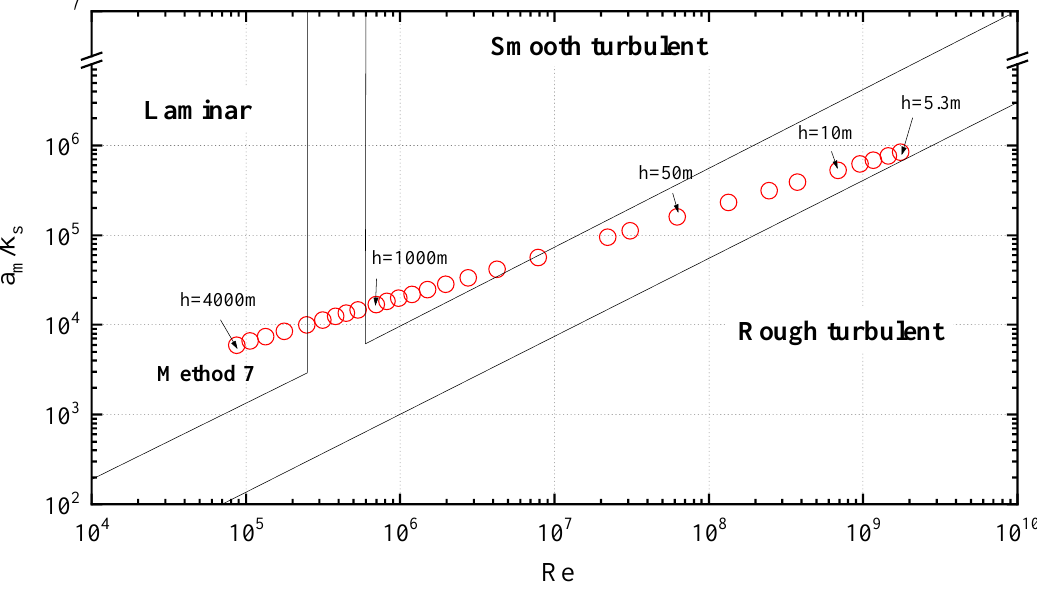
Figure 4. Variation of flow regime under shoaling tsunami (Method 7).